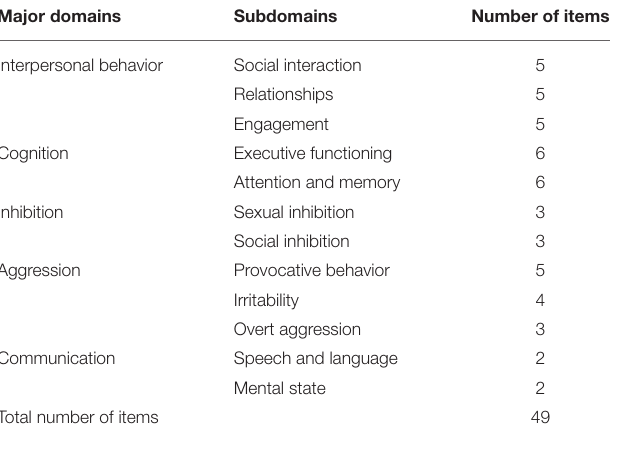
TABLE 1 | Major domains, sub-domains and number of item on SASNOS.